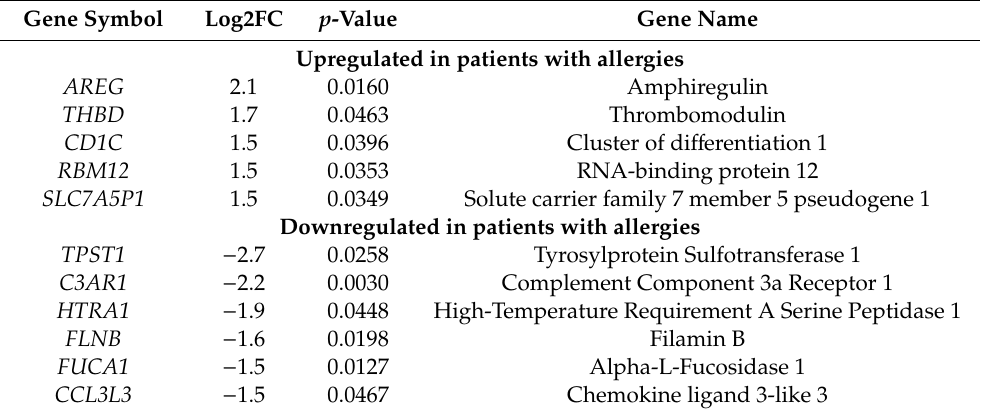
Table 1. Eleven upregulated and downregulated genes with p -values < 0.05 and | Log2FC | ≥ 1.5 in myeloid dendritic cells from patients with allergies compared with controls, as determined by RNA sequencing data.